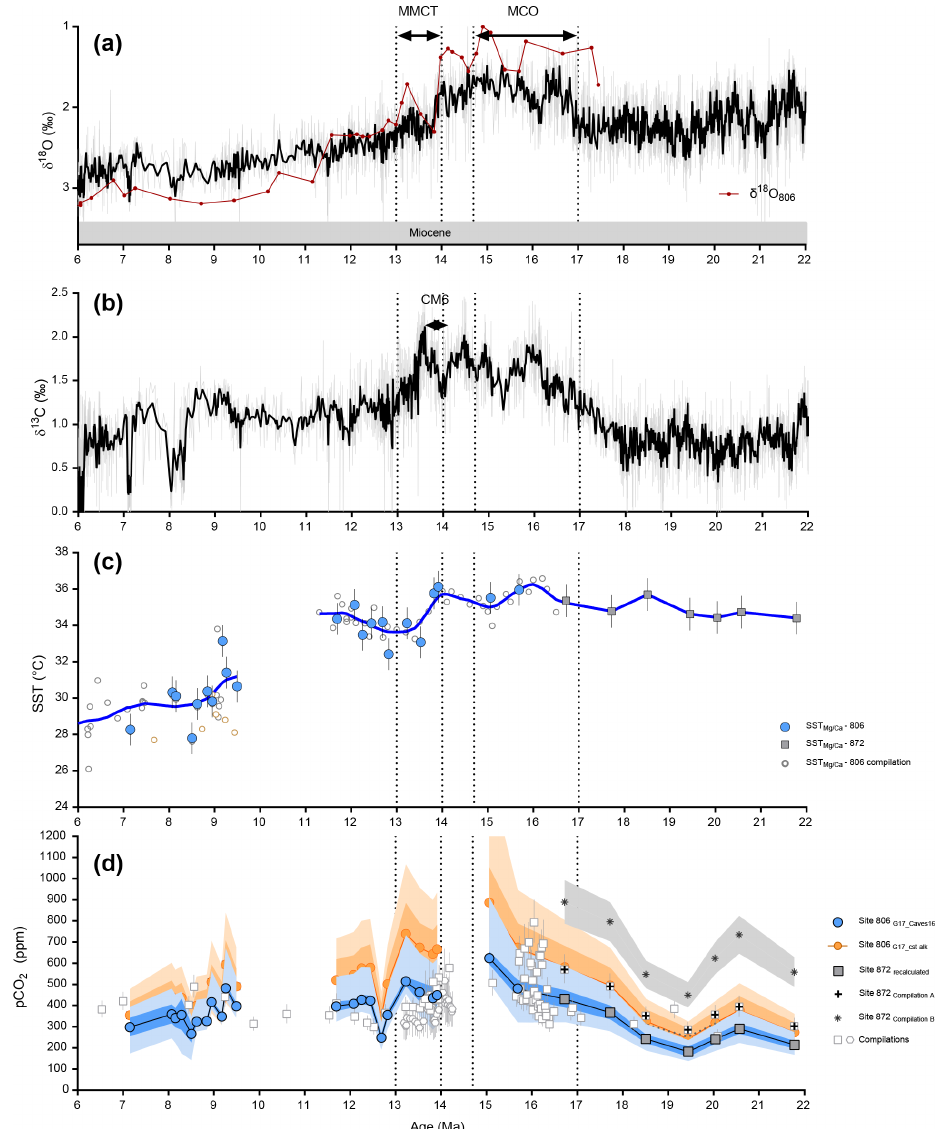
Figure 8. Proxy data from 22 to 6 million years, including the Middle Miocene Climate Transition (MMCT) and Miocene Climate Optimum (MCO), in the Western Equatorial Pacific compared to benthic oxygen isotope data. (a) Benthic δ 18 O (black line – compilation from Zachos et al., 2008). (b) Benthic δ 13 C (black line – compilation from Zachos et al., 2008). (c) – (d) Color indicates the site (filled light blue = 806, filled dark blue = 807), symbols represent the species (circle = T. sacculifer and triangle = G. ruber ), filled grey squares are recalculated data based on Sosdian et al. (2018) at site 872. (c) SST reconstructed at ODP Sites 806 and 807 using Mg / Ca ratios (see Supplement for reconstruction details), open symbols are reconstructed temperatures based on literature Mg / Ca at site 806 (see text or Fig. 4). (d) Reconstructed p CO 2 (ppm) from this study (blue symbols) using boron-based pH and alkalinity from Caves et al. (2016). Propagated uncertainties are given by Eq. (S17) for the dark blue envelope, while the light blue envelope reflects the uncertainties calculated based on Eq. (S16) (taking into account uncertainty on δ 11 B seawater ). Orange data points and envelope are calculated p CO 2 values and associated uncertainty from our study using our framework and a constant alkalinity scenario. Open squares (compilation A) are compilation data from Sosdian et al. (2018), open triangles are data from Raitzsch et al. (2021) at Site 1092. Crosses are original p CO 2 calculated in Sosdian et al. (2018) at Site 872; asterisks are recalculated p CO 2 at Site 872 by Rae et al. (2021); dark red triangles are from Site 1092 (Raitzsch et al., 2021). Data for compilation A are from Hönisch and Hemming (2009); Seki et al. (2010); Foster et al. (2012); Badger et al. (2013); Greenop et al. (2014); Martínez-Botí et al. (2015a); Chalk et al. (2017); Sosdian et al. (2018). Data for compilation B are from Foster (2008); Hönisch and Hemming (2009); Seki et al. (2010); Foster et al. (2012); Badger et al. (2013); Greenop et al. (2014); Martínez-Botí et al. (2015a); Chalk et al. (2017); Dyez et al. (2018); Sosdian et al. (2018); Greenop et al. (2019); de la Vega et al. (2020).